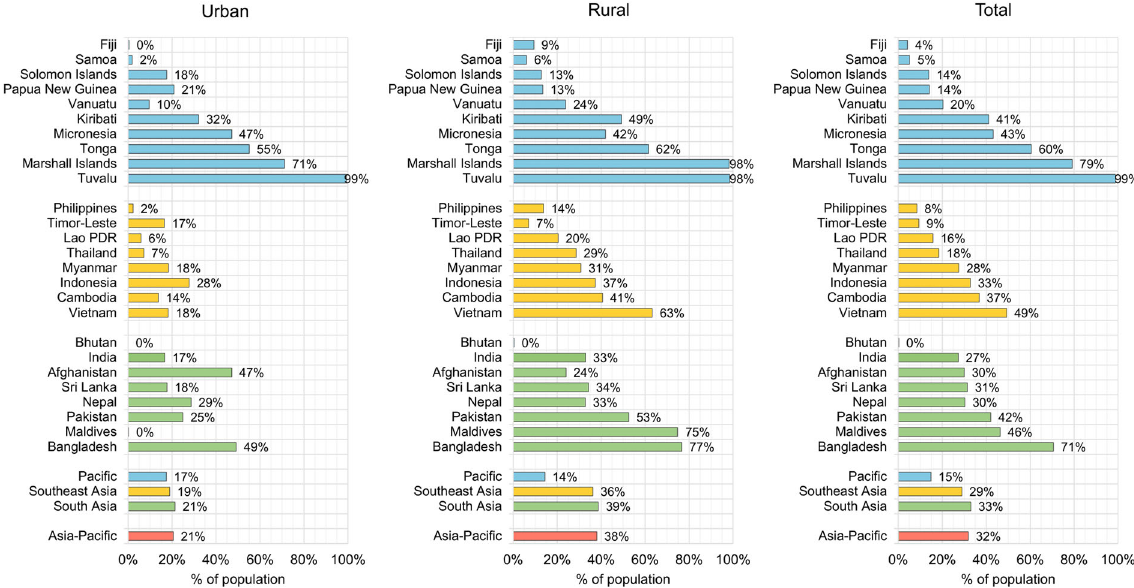
Fig. 1 Proportion of population using self-supply as a main drinking water source. Proportions are based on most recent data from national surveys and censuses. Blue coloured bars represent countries in the Paci fi c, orange coloured bars represent countries in Southeast Asia, green coloured bars represent countries in South Asia and red bars represent Asia-Paci fi c (all countries combined). These crude estimates, which do not factor in temporal trends, suggest 32% of the population (~780 million people) in the Asia-Paci fi c used self-supply as their main drinking water source in 2018. Self-supply is more common in rural areas (38% of the rural population) than in urban areas (21% of the urban